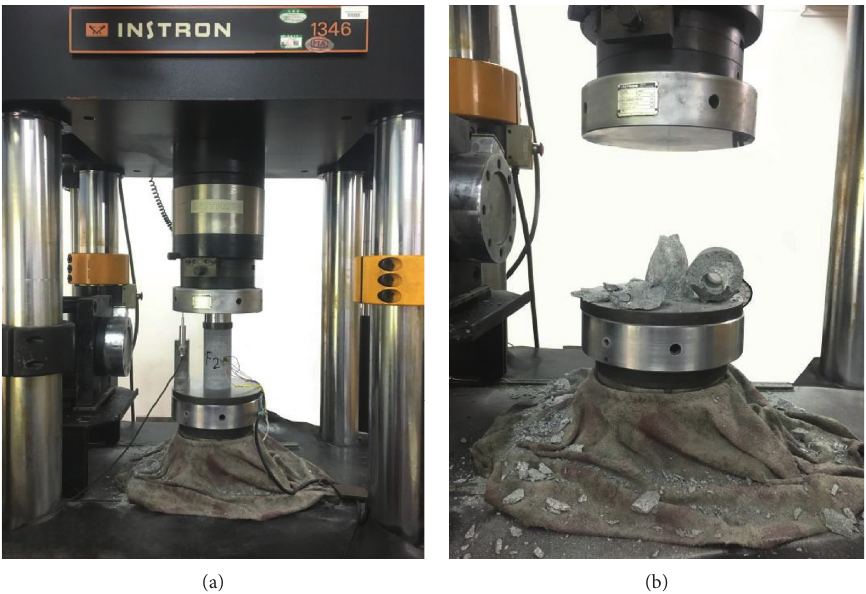
Figure 9: Instron 1346 universal material testing machine and diagrammatic sketch of experimental